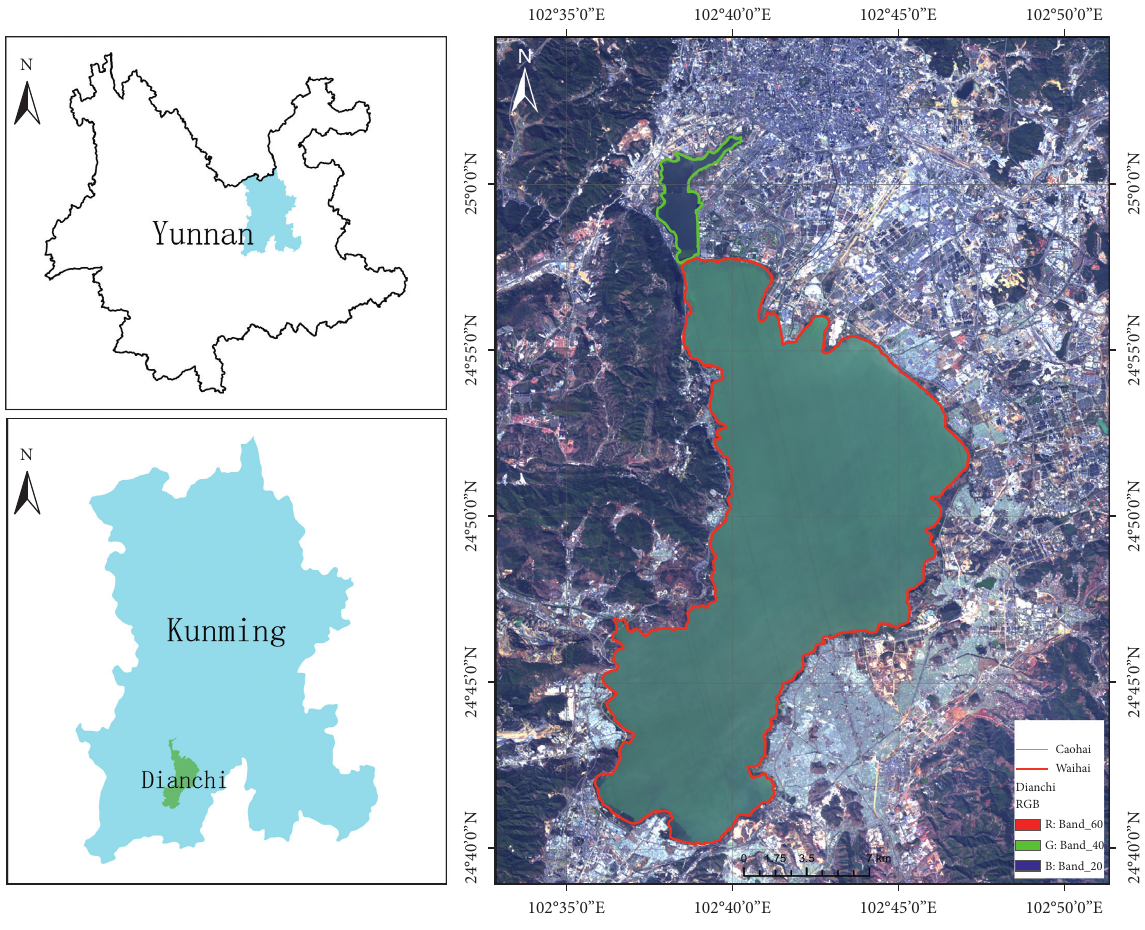
Figure 1: Location of the study area. Table 1: Basic parameters of GF-5 hyperspectral